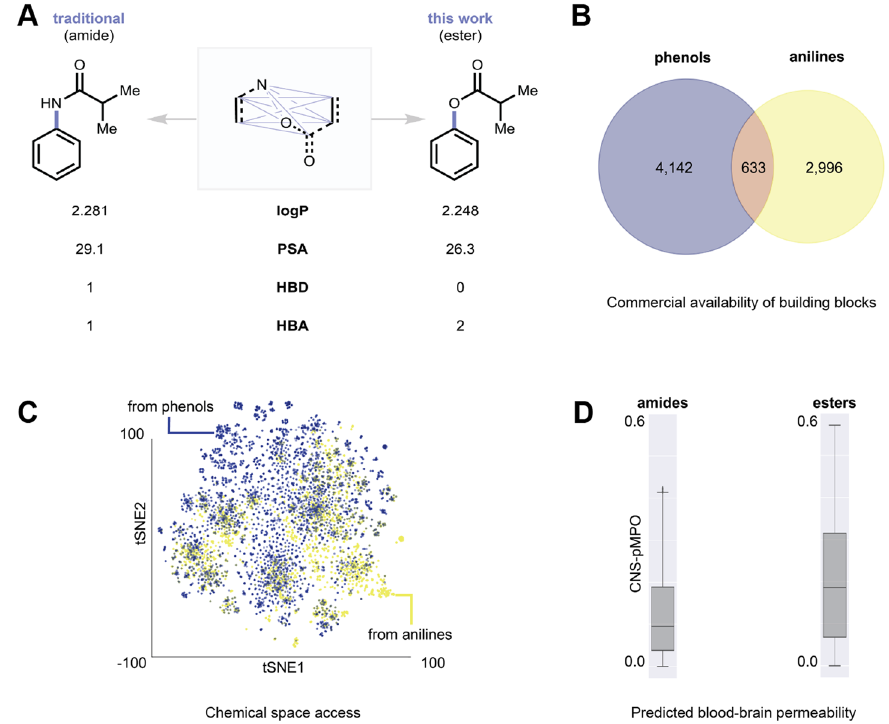
Fig. 2 Physicochemical properties of amides and esters and complementary chemical space of anilines to phenols. A An amine and carboxylic acid can be coupled in a variety of transformations beyond the traditional amide coupling, including the esteri fi cation reaction developed here, which gives a unique property footprint. B Venn diagram showing the complementarity of phenol to aniline building blocks available in the MilliporeSigma catalog. C tSNE analysis showing the complementarity of ester products generated by coupling aspirin to phenol (blue dots) versus aniline (yellow dots) building blocks available in the MilliporeSigma catalog. D Ester products have a higher predicted blood – brain permeability (CNS-pMPO score) than classic amide products produced from the same set of anilines when coupled to the drug